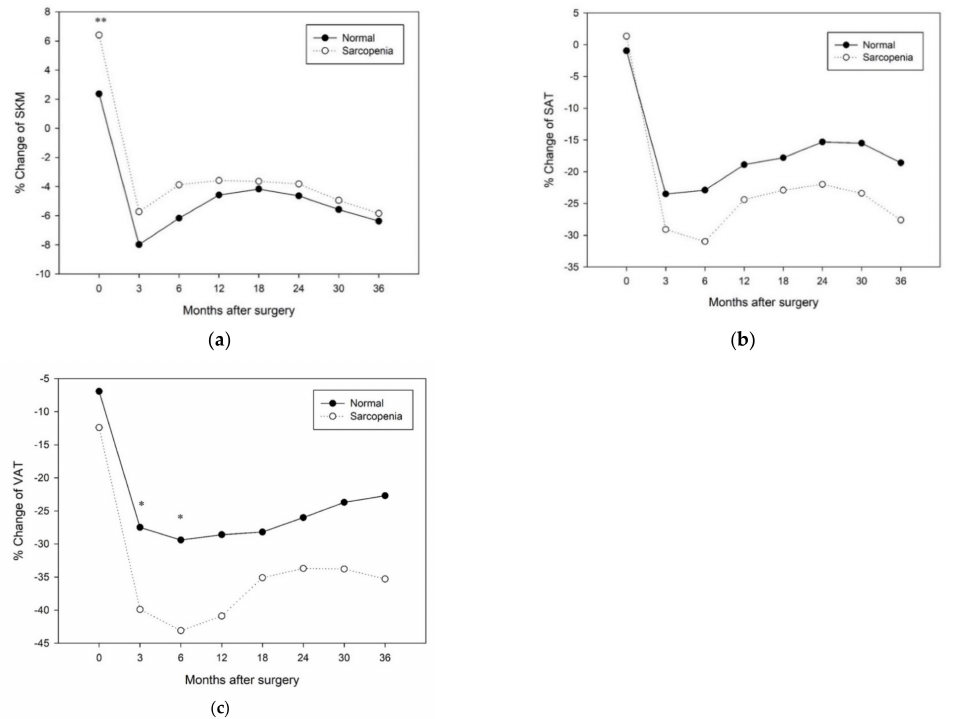
Figure 3. Change in longitudinal body composition according to preoperative sarcopenia: ( a ) % change of skeletal muscle mass (SKM) after surgery; ( b ) % change of subcutaneous adipose tissue (SAT) after surgery; ( c ) % change of visceral adipose tissue (VAT) after surgery. Statistical significance between groups (Student’s t -test; * p < 0.05, ** p <